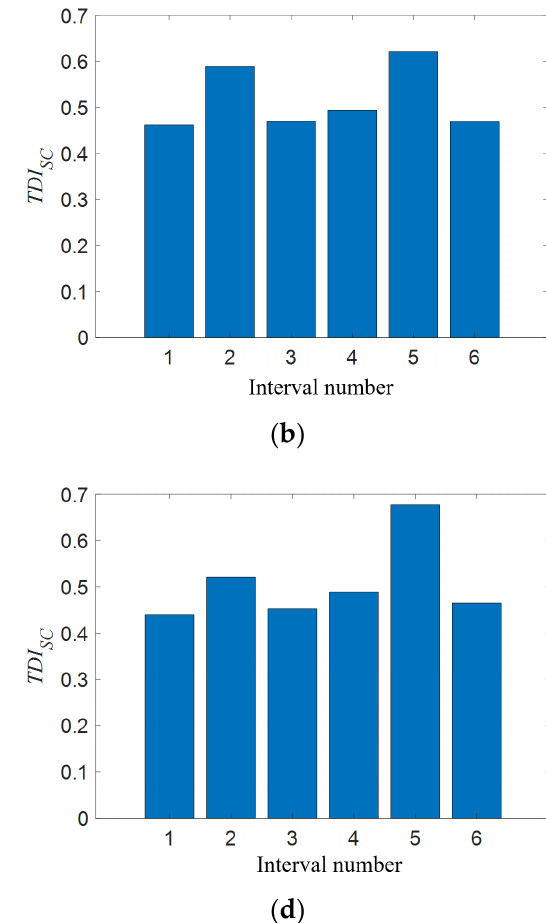
Figure 18. Verification of single stiffness damage in different degrees: ( a ) power spectrum curve of the tunnel acceleration under different degrees of stiffness damage in the second interval and ( b ) TDI SC at different degrees of stiffness damage in the second interval.